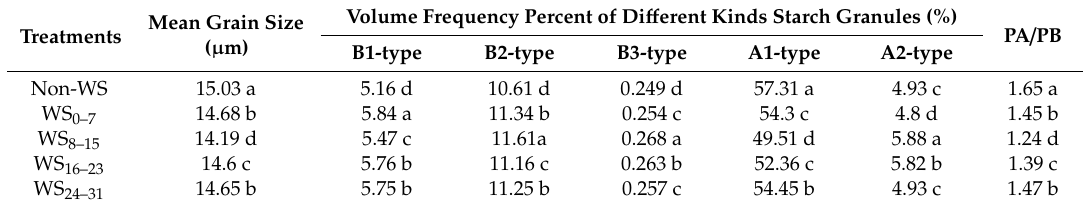
Table 2. E ff ect of combined waterlogging and shading stress during post-anthesis on the size and volume percent distribution of di ff erent kinds of starch granules in wheat grains at maturity.